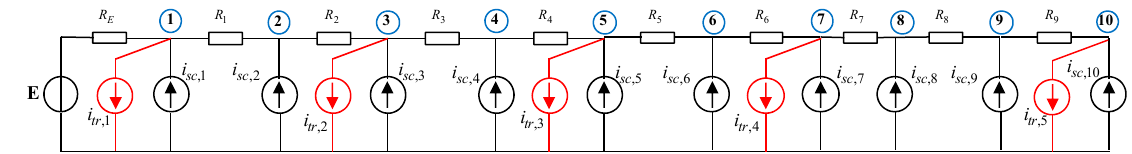
Figure 4. Model of the electric scheme shown in Figure 6.